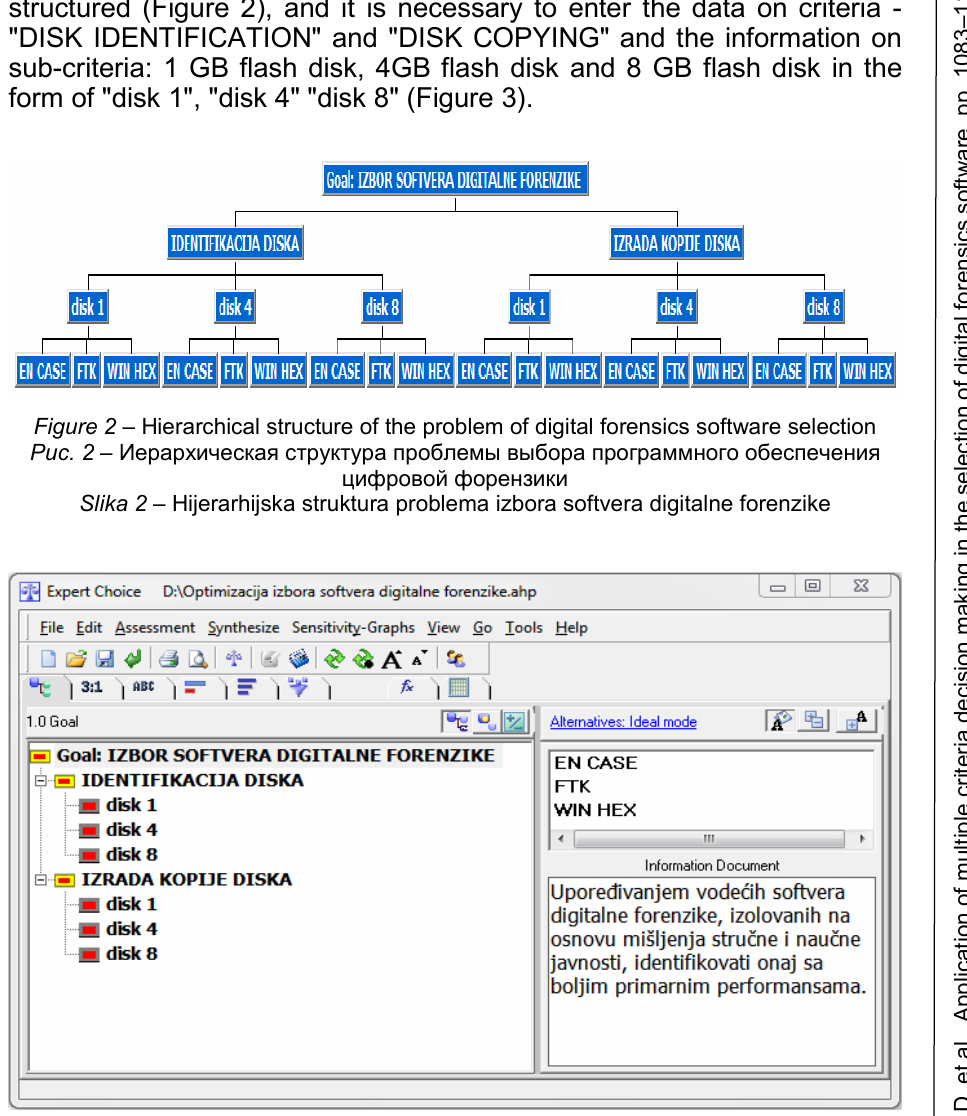
Figure 3 – Defining criteria and sub-criteria in EC 2011 program Рис . 3 – Определение критериев и субкритериев в программе ЕС